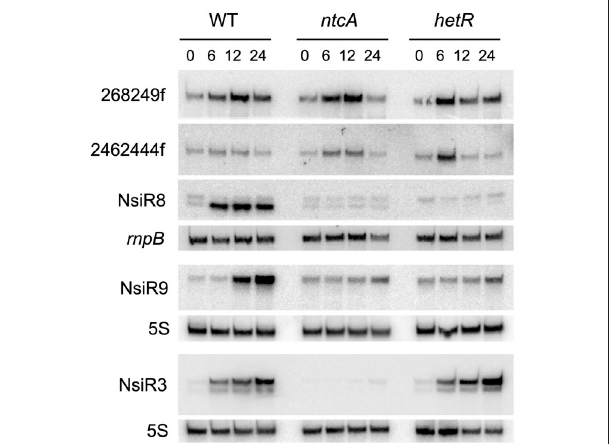
FIGURE 5 | Expression of several predicted sRNAs in Nostoc sp. PCC 7120. RNA samples were isolated from cells of the wild type (WT) or ntcA and hetR mutants subjected to nitrogen deficiency for the number of hours indicated and subjected to Northern blot with probes corresponding to sRNAs 268249f, 2462444f, and NsiR8 (membrane 1), NsiR9 (membrane 2), and NsiR3, included for comparison (membrane 3). rnpB (membrane 1) or 5S RNA (membranes 2 and 3) were used as loading and transfer controls.